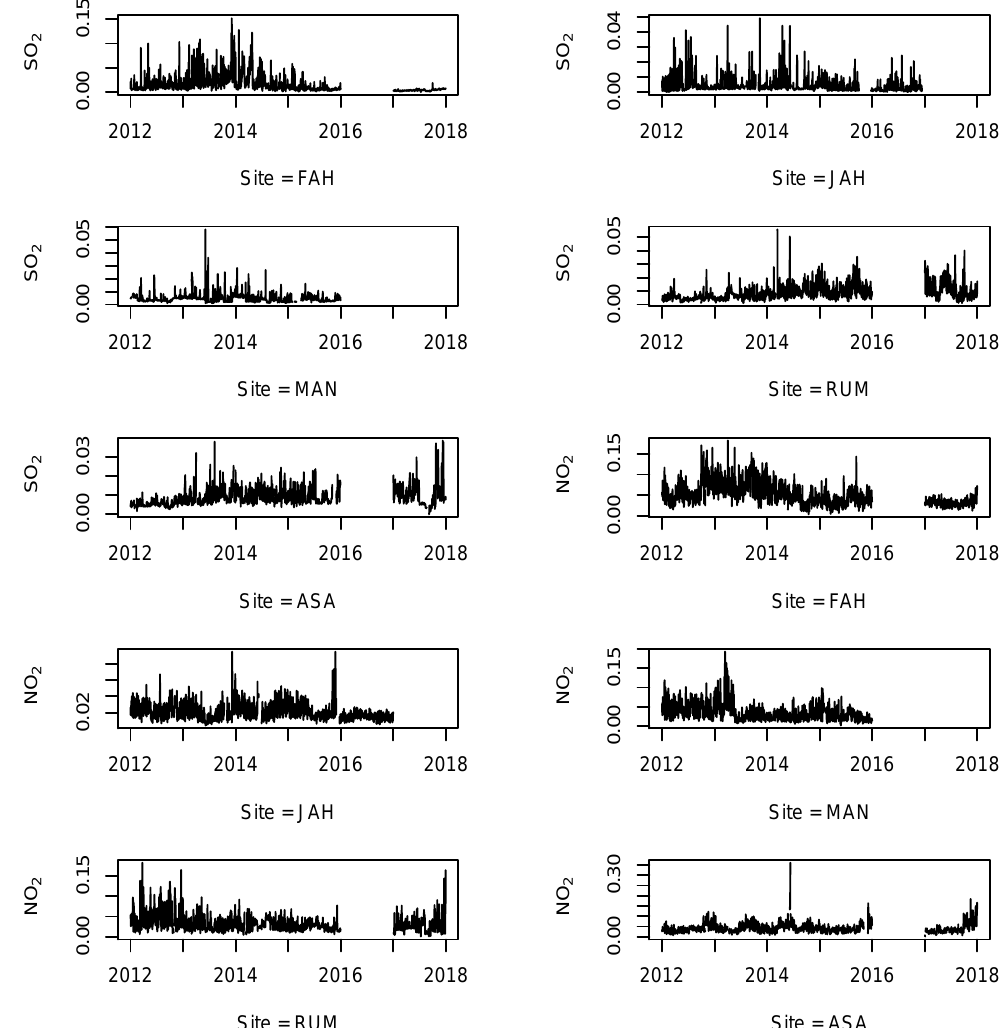
Figure 2. Time-series of air quality monitoring for SO 2 and NO 2 from 2012 to 2017, with missing values from five different locations (stations) in the State of